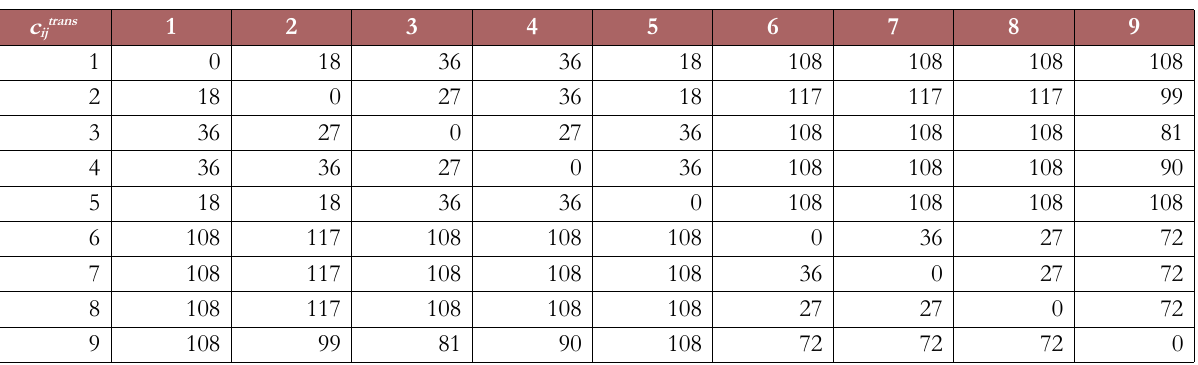
Table 5. The unit transportation cost between countries